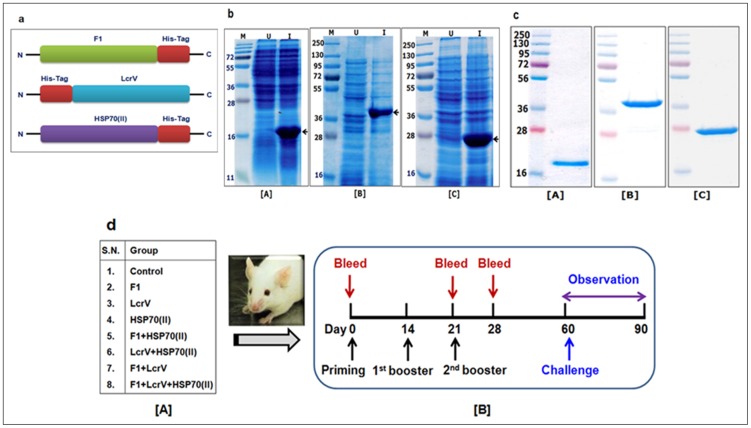
a. Schematic diagram of three recombinant vaccine candidates; F1, LcrV and HSP70(II) showing the histidine tag and orientation of the open reading frame.
b. 16% SDS-PAGE analysis of F1 protein expression [A]. 12% SDS–PAGE analysis of LcrV [B] and of HSP70(II) domain II of M. tuberculosis protein expression in E. coli [C]. The panels depict protein molecular mass marker (lane M), and Coomassie-stained polypeptide profiles of E. coli lysates un-induced (lane U) and induced with IPTG (lane I). The arrows at the right of the panels indicate the position of expressed recombinant proteins. c. SDS-PAGE analysis of purified F1 [A], LcrV [B] and HSP70(II) domain II of M. tuberculosis [C] metal affinity chromatography using Ni-NTA column. Each purified protein (3 µg/well) was analysed on SDS-PAGE. d. The humoral and cell mediated immune responses, protective potential and histopathological examinations of F1 and LcrV from Y. pestis with or without HSP70(II) of M. tuberculosis were evaluated in a mouse model. [A] Balb/C mice (8/group) were immunized with plague vaccine candidates with HSP70(II) as an immunomodulator in formulation aluminium hydroxide gel. [B] Schematic representation of immunization schedule following challenge experiments.